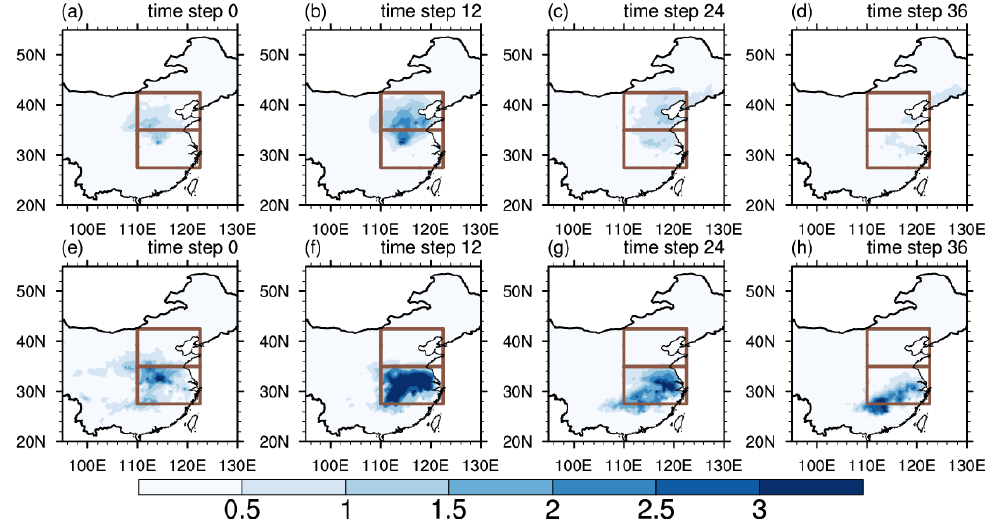
Figure 3. Evolution of 12-h accumulative precipitation (colors, mm) from time step 0 to 36 for ISEs in ( a – d ) NC and ( e – f ) the YRV region. The 12-h accumulative precipitation with surface temperature above the freezing point has been masked.